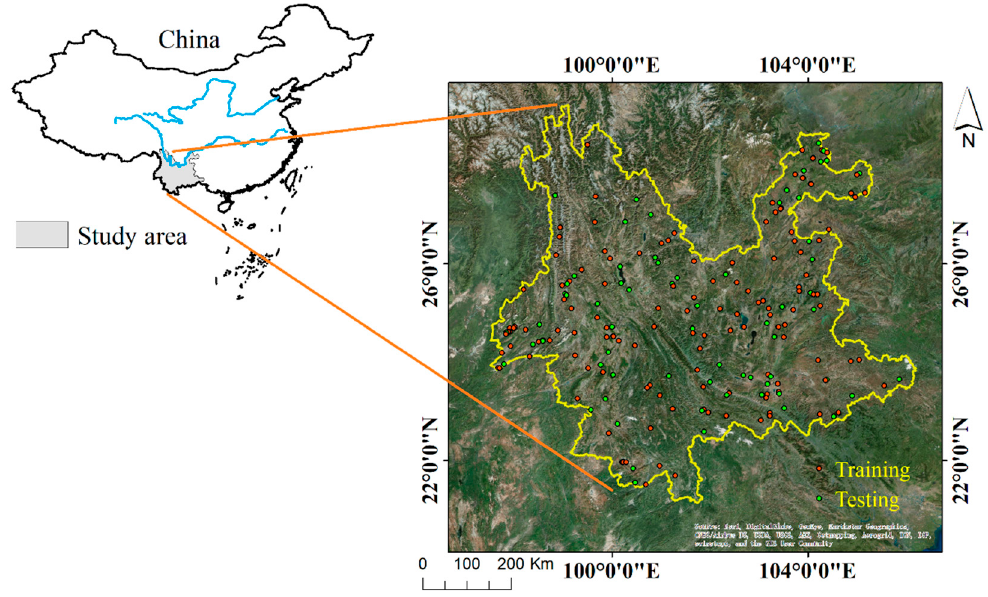
Figure 1. Location of the study area and the distribution of flash flood inventories (red for training and green for testing) from 2011 to 2015 in Yunnan Province, China.